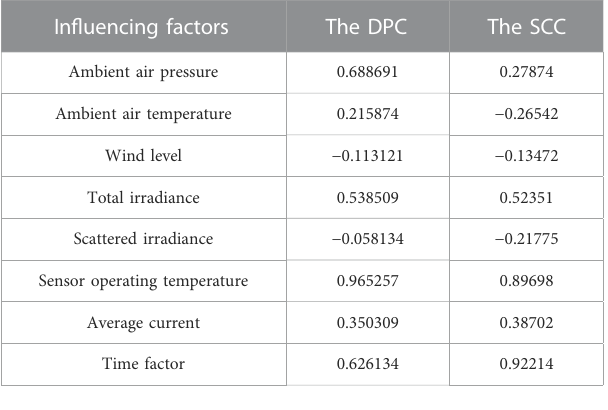
TABLE 4 The optimal